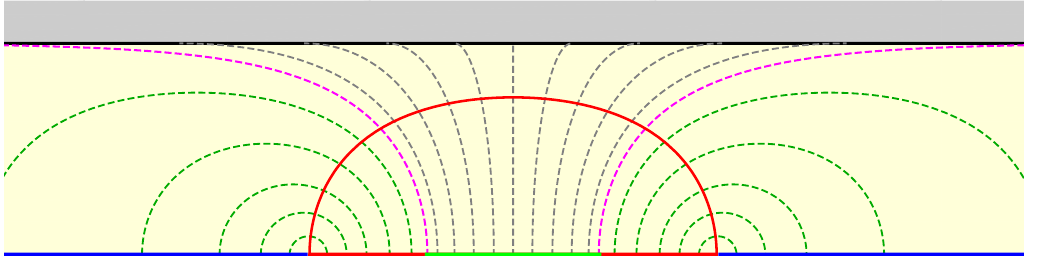
Figure 7 . Geodesic bit threads in BTZ black brane geometry for an interval on the line. The red solid curve is the RT curve (6.3). The green segment corresponds to A β (see section 5.1).